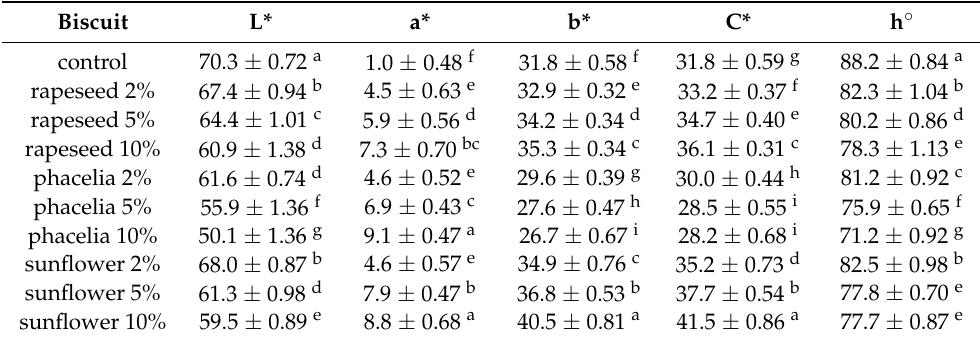
Table 4. CIELAB colour coordinates, chroma and hue angle of biscuits.